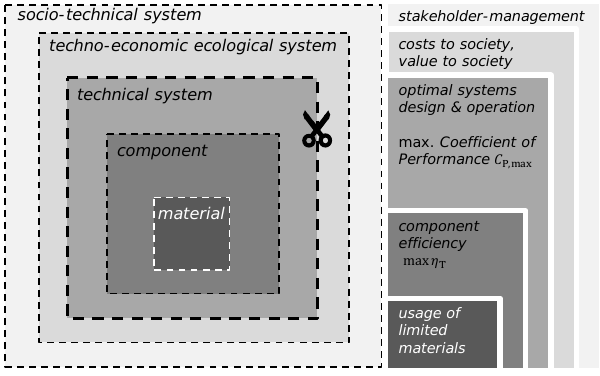
Fig. 1. Technical systems are embedded in a socio-technical environ- ment of stakeholders. The focus of this paper is the optimal design & operation of the technical system consisting out of the tidal channel, the basins and the turbine